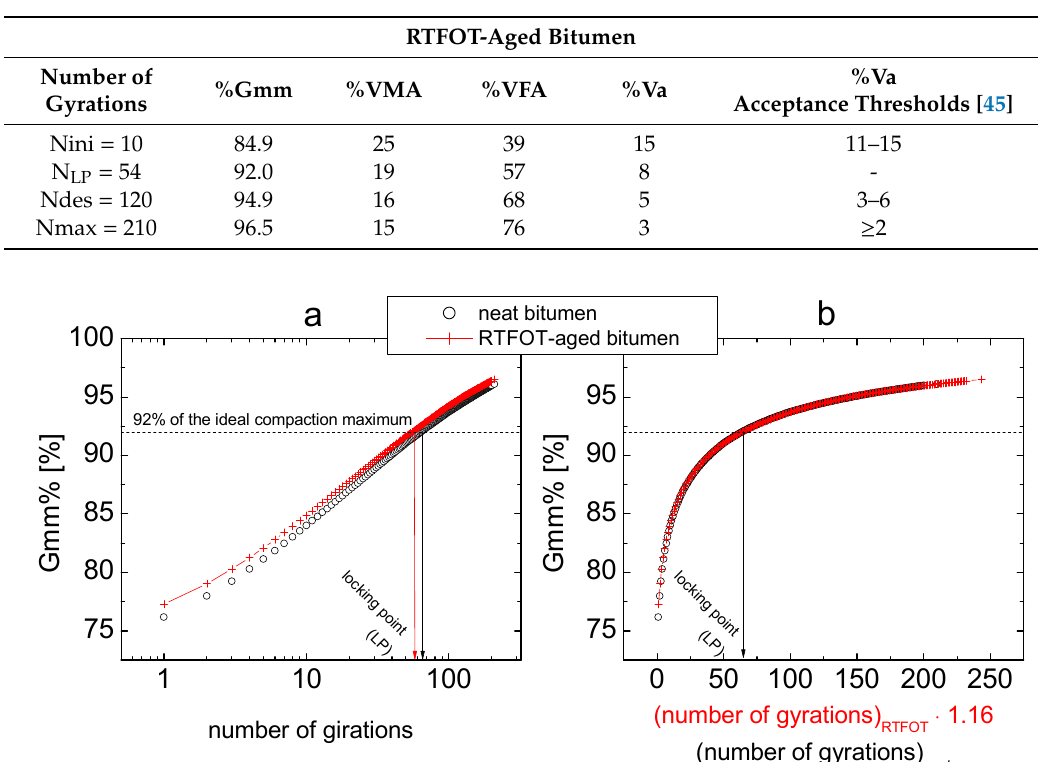
Figure 4. Gmm% as a function of the number of gyrations. Panel ( b ) shows he same data of panel ( a ) with scaled